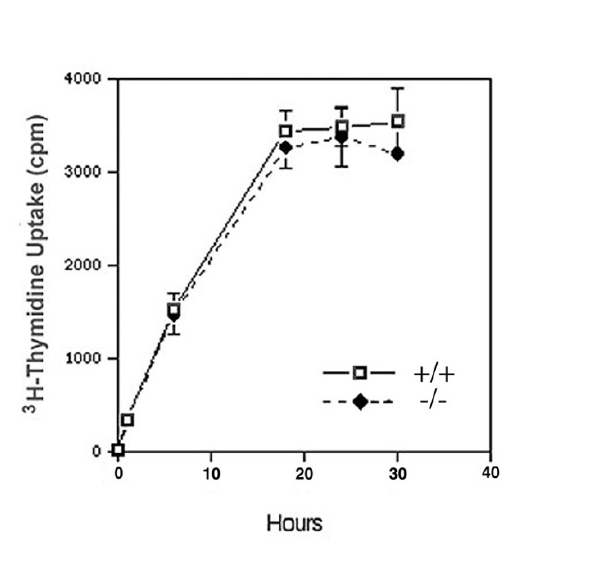
Figure 6 Contraction of collagen gels by wild-type (+/+) and SPARC- null (-/-) fibroblasts. Cells were incorporated in collagen gels and incubated in DMEM plus 2% FBS. Data represent the average of three independent experiments, each performed in